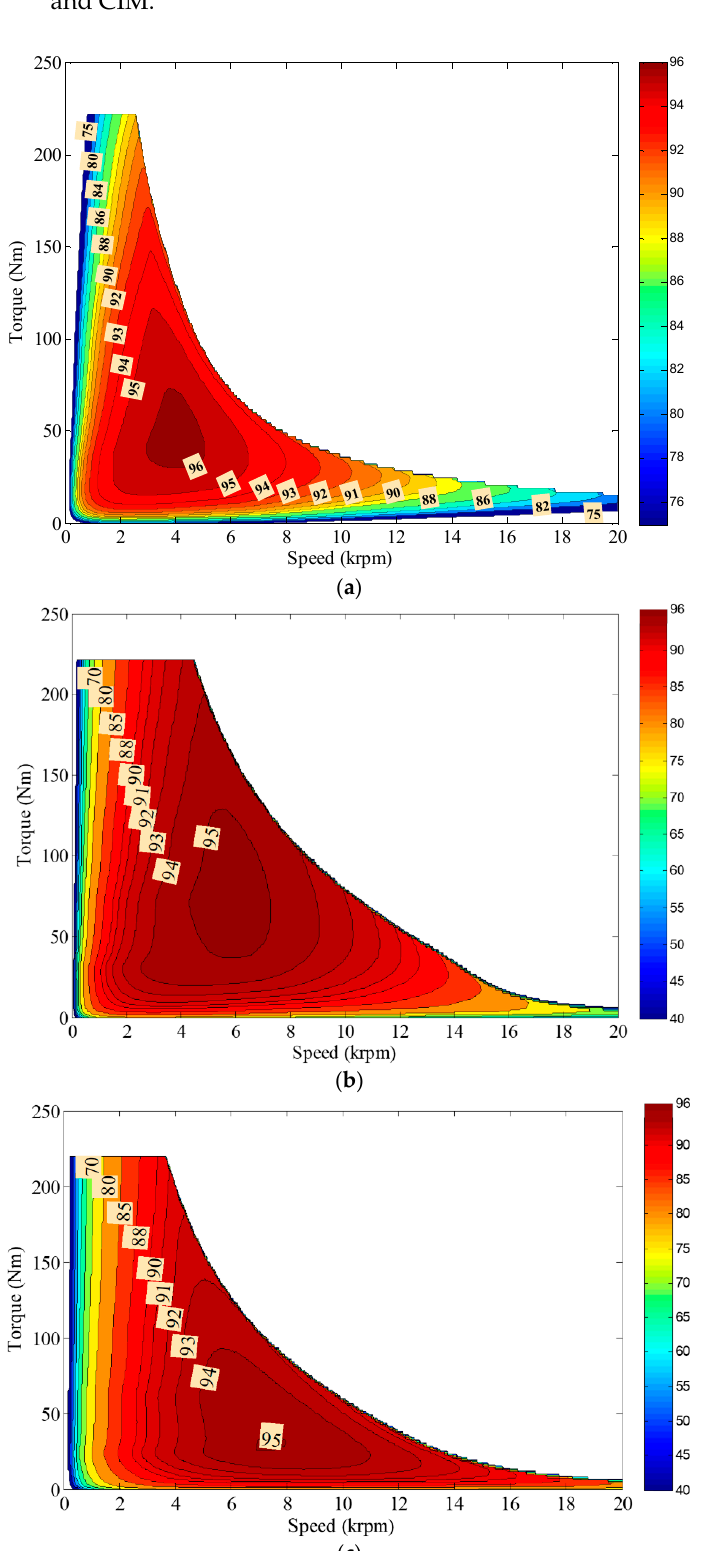
Figure 7. Comparison of the efficiency maps of the considered machines. ( a ) IPM machine. ( b ) CIM. ( c )